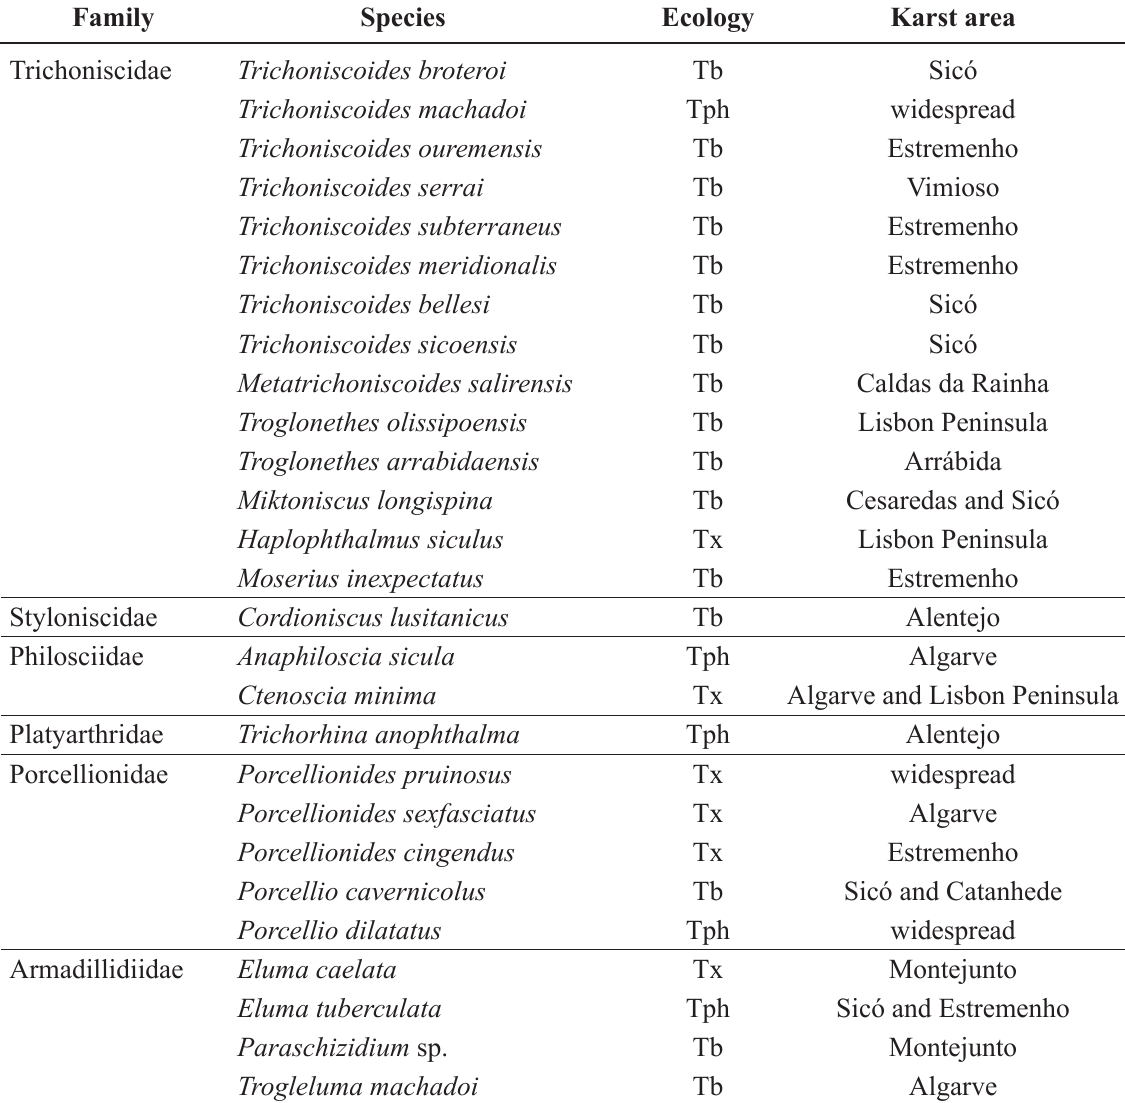
Table 2. Terrestrial isopod species recorded in subterranean habitats of karst areas from Portugal, with ecological classification. Tb = troglobiont; Tph = troglophile; Tx =